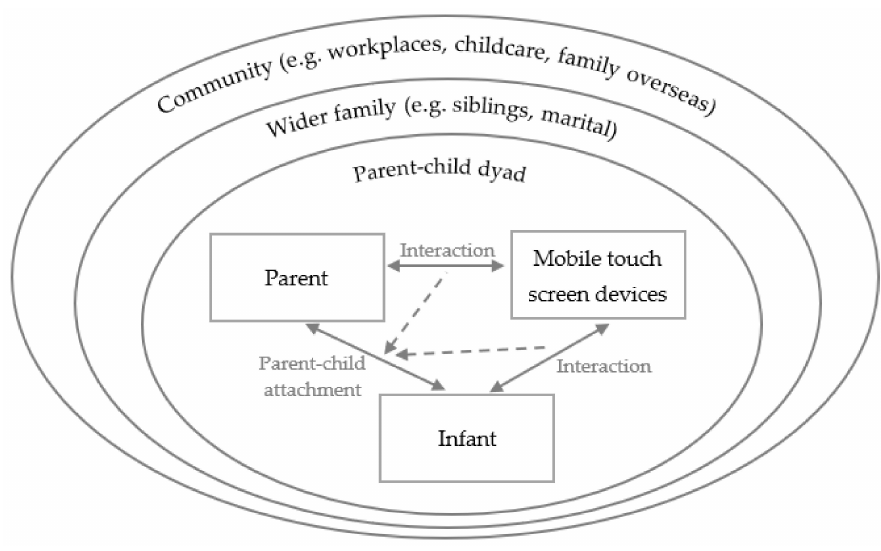
Figure 1. Mobile touch screen device use in an integrated family